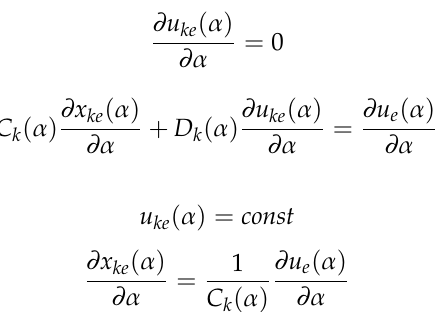
( ) / x α α∂ ∂ . The results are plotted in Figure 8. ke